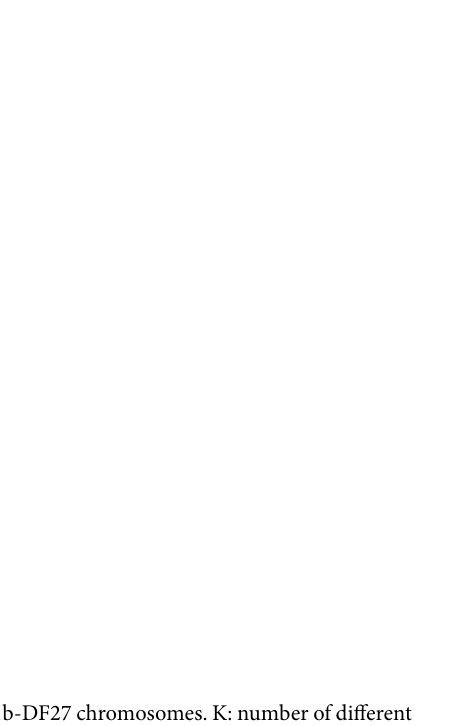
Table 2. Diversity parameters for STR variation within R1b-DF27 chromosomes. K: number of different haplotypes; Dhap: haplotype diversity; Var: average STR allele repeat size variance; sd: standard deviation across loci of